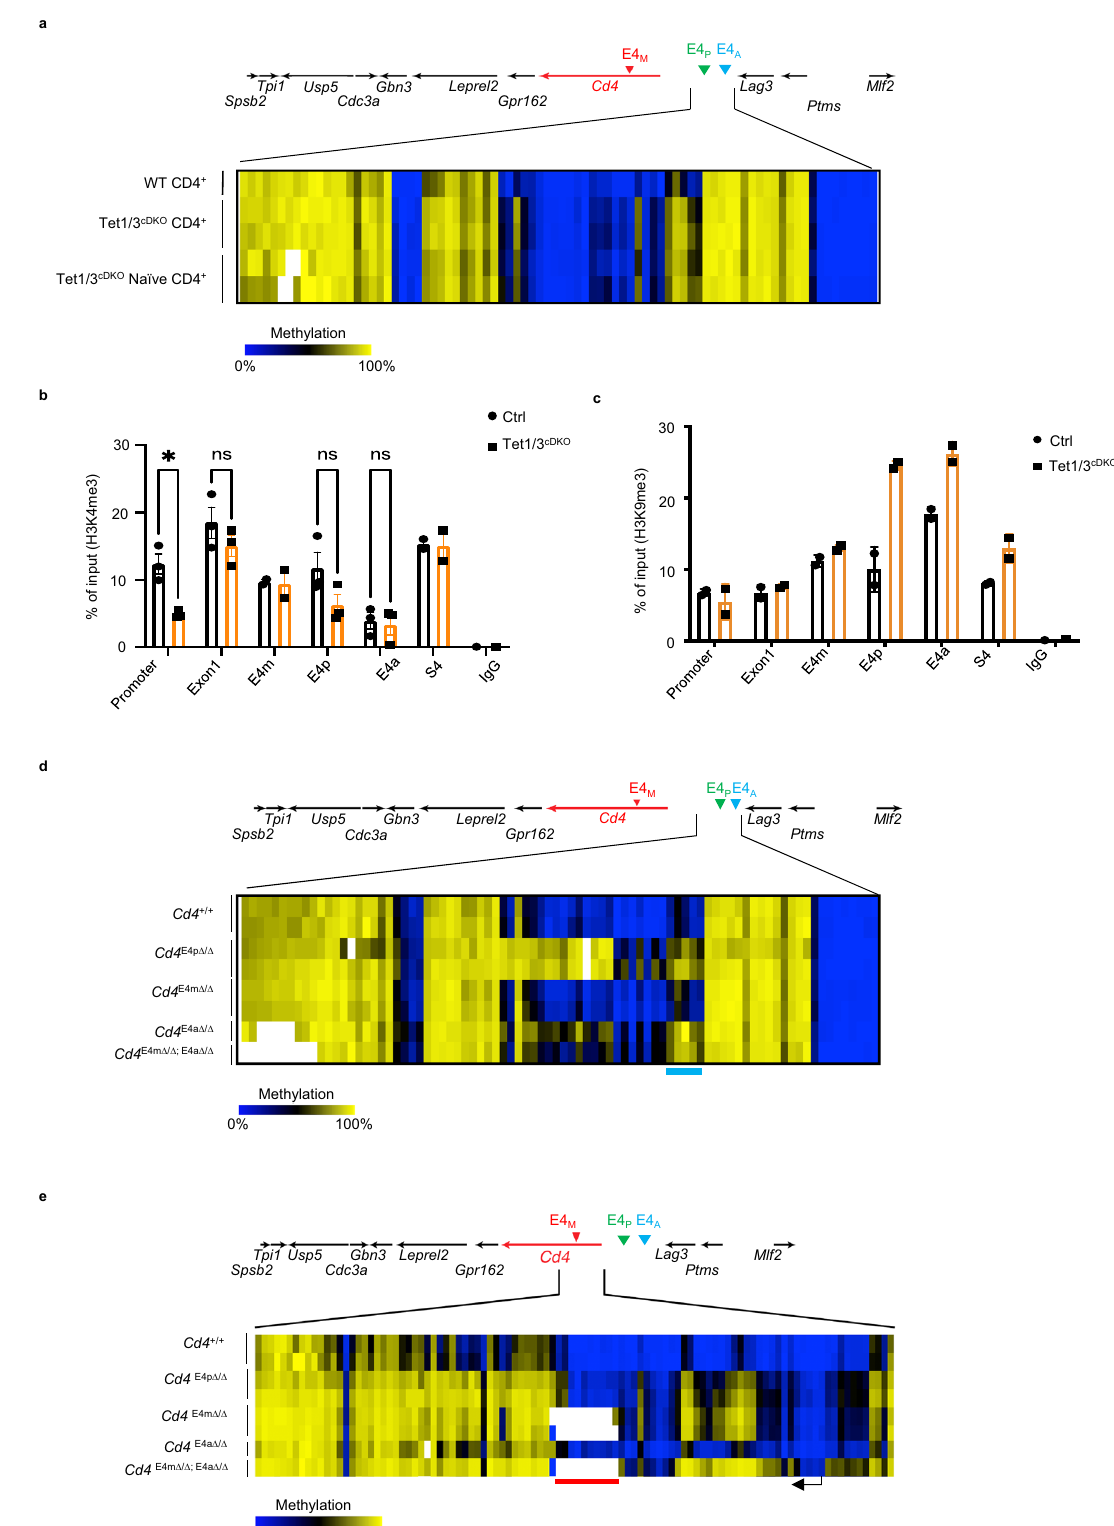
DNA demethylation and that lack of demethylation would impair gene expression in effector T cells by impairing the activity of stimulus-responsive CREs. Of the 6719 genes that underwent a fold change >2 in gene expression from DN3 to CD4 single-positive (SP) T-cell speci fi cation in the thymus, 409 genes (10.8%)